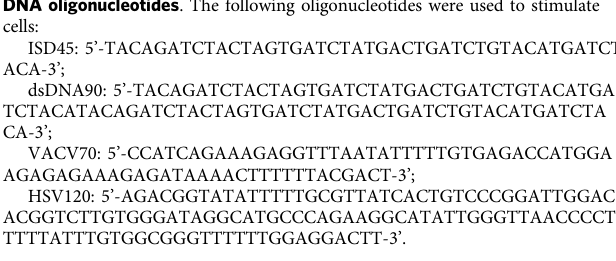
Fig. 7 ZCCHC3 is important for cytosolic dsDNA-induced oligomerization of cGAS. a Effects of ZCCHC3 on self-association of cGAS. HEK293 cells were transfected with the indicated plasmids for 20 h. The cells were then left un-treated or treated with HSV120 for 4 h before co- immunoprecipitation and immunoblotting analysis with the indicated antibodies. b Effects of ZCCHC3-de fi ciency on self-association of cGAS. ZCCHC3-KO and control HEK293 cells were transfected with the indicated plasmids for 20 h before co-immunoprecipitation and immunoblotting analysis with the indicated antibodies. c Effects of ZCCHC3-de fi ciency on oligomerization of cGAS induced by transfected VACV70. Zcchc3 + / + and Zcchc3 − / − MLFs were left un-treated or treated with VACV70 for 4 h. Cell lysates were then fractionated by SDD-AGE and SDS-PAGE and analyzed by immunoblots with the indicated antibodies. Data are representative of three experiments with